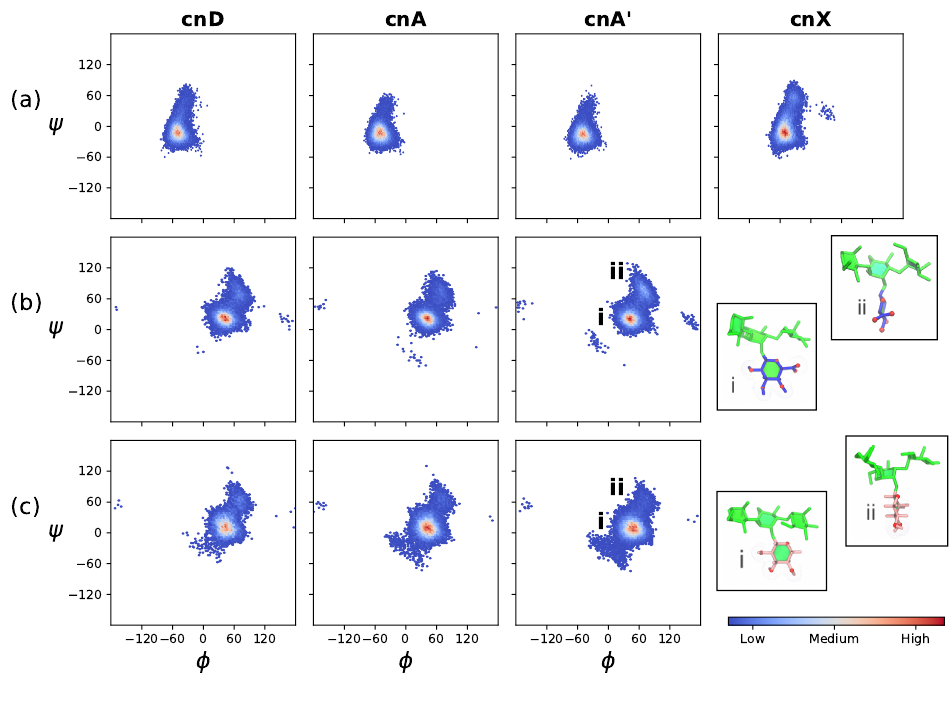
Figure 4. Heat maps of the glycosidic linkage orientation distribution over the last 400 ns of simulation in the two central RUs (RU3 and RU4) in the GXM chains. Row ( a ) shows the backbone α DMan(1 → 3) α DMan linkage, row ( b ) the β DGlcA(1 → 2) α DMan side chain linkage and row ( c ) the β DXyl(1 → 2) α DMan side chain linkage. Glycosidic linkage orientations are shown as rotations of the linkage dihedral angles φ and ψ . The insets in row ( b , c ) show the major face-on ( i ) and minor edge-on ( ii ) orientations of the β (1 → 2)-linked side chains relative to the mannan backbone. The residues and substitutions are coloured as follows: α DMan—green; β DGlcA—blue; β DXyl—pink; and